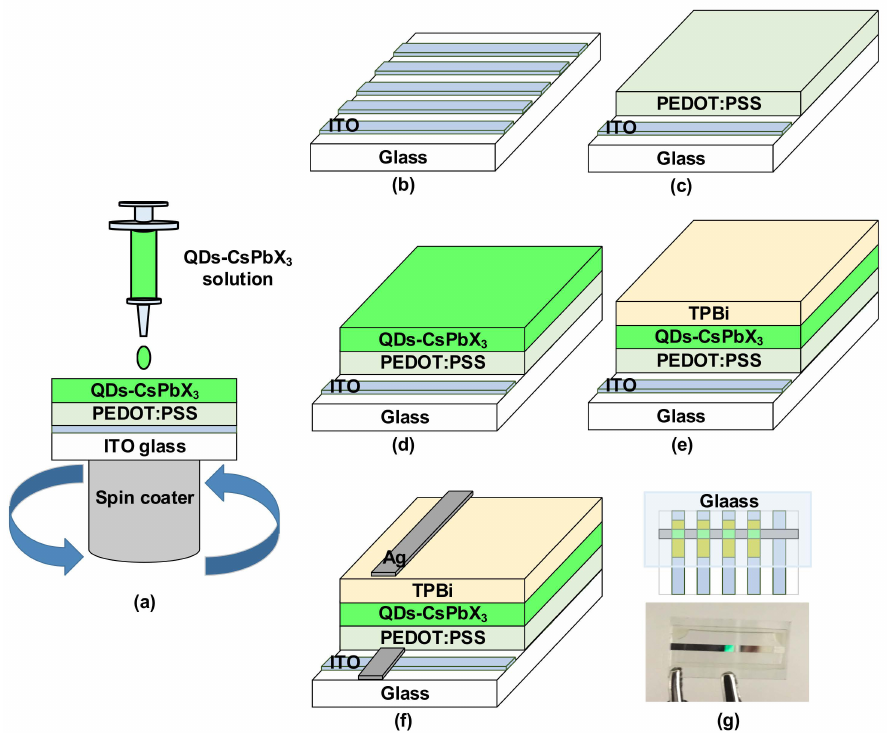
Figure 2. Perovskite QDs-CsPbX 3 light-emitting diode (LED) process steps. ( a ) QDs-LED device spin-coating process schematic diagram; ( b ) Patterned ITO-coated glass; ( c ) PEDOT:PSS hole injection layer preparation; ( d ) QDs-CsPbX 3 active layer preparation; ( e ) 1,3,5-Tris(1-phenyl-1H-benzimidazol-2-yl) benzene (TPBi) electron transport layer deposition; ( f ) Ag electrode deposition; ( g ) Original QDs-LED device picture.